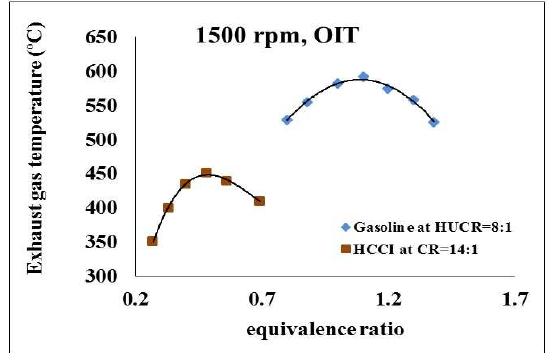
Fig. 7. Exhaust gas temperatures of the two